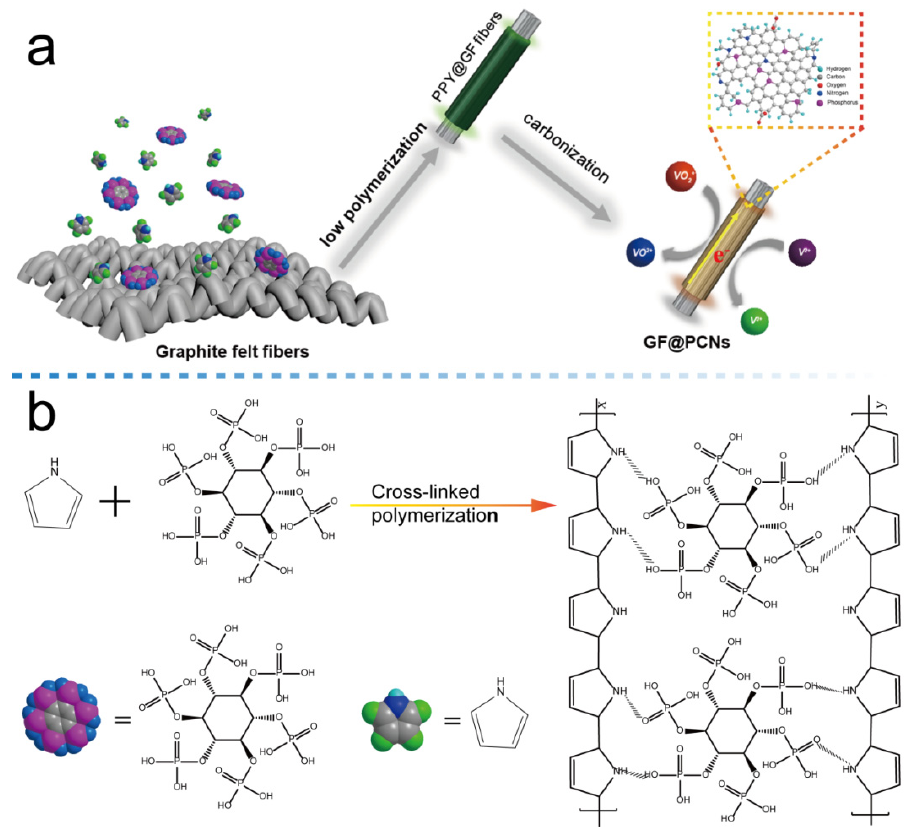
Figure 1. ( a ) The preparation process of GF@PCNs electrode, ( b ) Schematic diagram of cross-linking reaction on the surface of GF@PCNs.